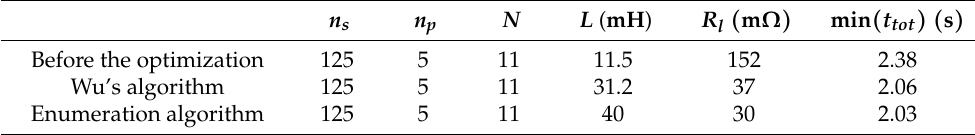
Table 6. Comparison results of the two